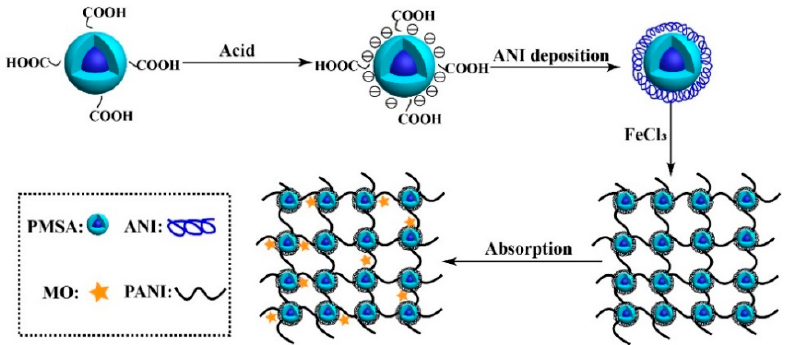
Figure 1. Schematic illustration of the preparation of polyaniline (PANI)/poly(styrene–methyl methacrylate–acrylic acid) (PSMA) adsorbent.